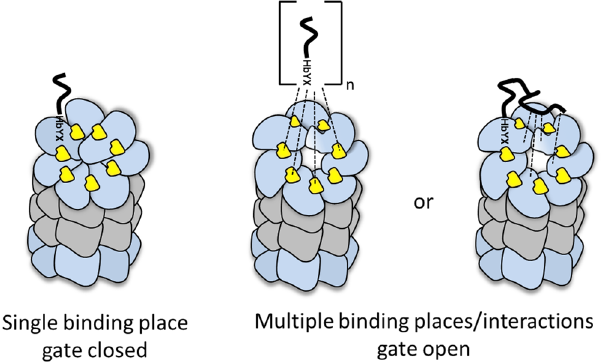
Figure 6. Revisited model of proteasome activation supporting all currently available data. Binding of a sigle HbYX motif is not sufficient to allow substrate access. Only interaction at multiple HbYX binding sites or at a single site together with secondary interactions allow for efficient proteasome